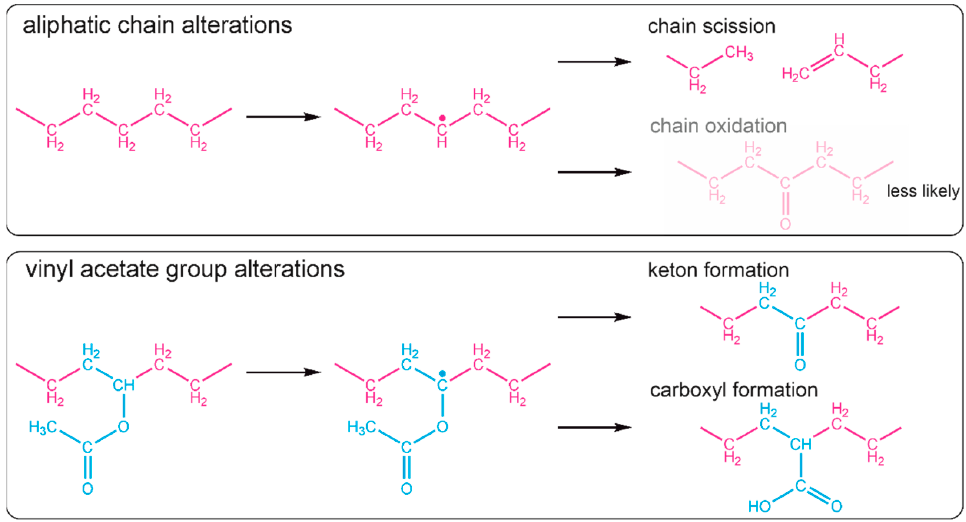
Figure 5. Possible reaction paths of Et or VAc blocks of EVA macromolecules during MAPLE process. The presence of new CH 3 groups and C=C bonds in the EVA copolymer structure will consequently have an influence on the absorption of the band at 1371 cm − 1 (orange circles), which was originally associated with the methylene group of the vinyl acetate